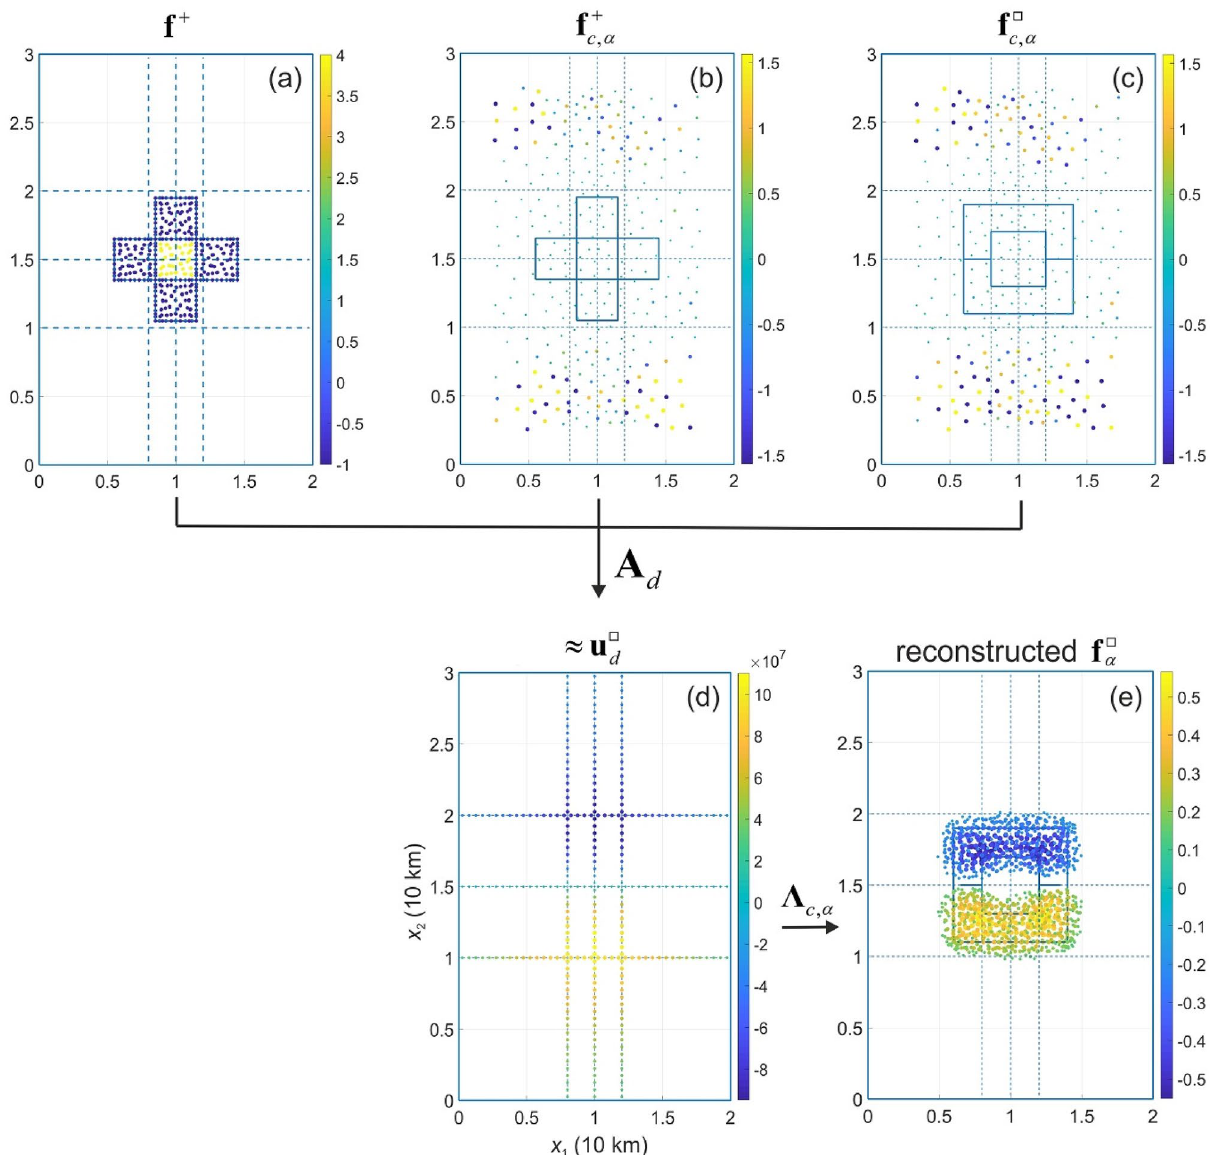
(cid:31) by cloaking of the current source density f + ( a ; see (cid:31) c , α ( c ). Panel ( d ) represents a composition data on electric